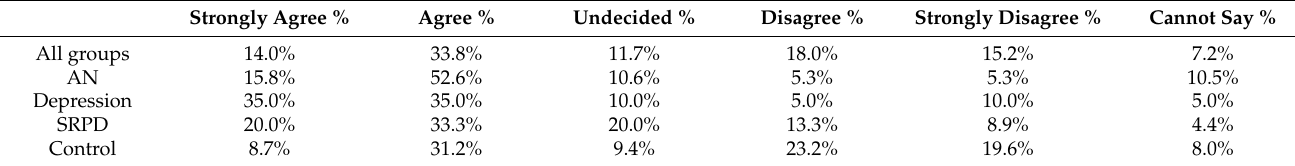
Table 2. Percentual distribution of responses on worsening of perceived quality of life due to COVID- 19 restrictions by